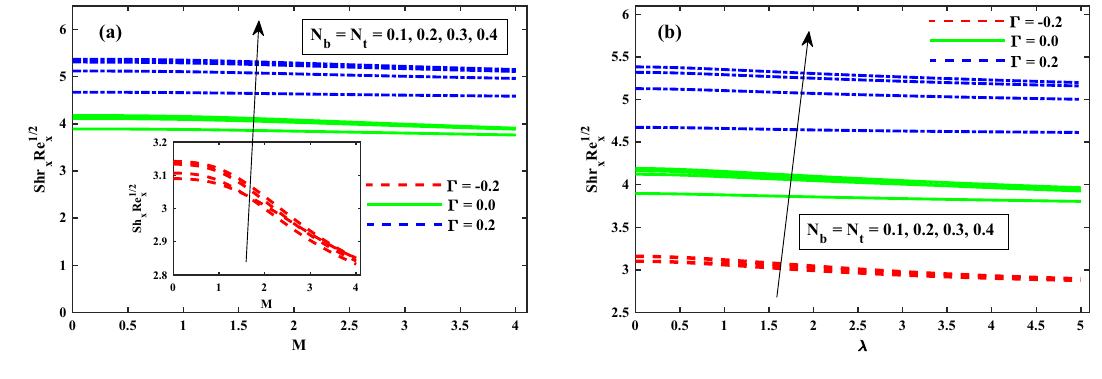
Figure 15. Fluctuation of Shr x Re 1 x / 2 against N b , N t , M , and (cid:31)